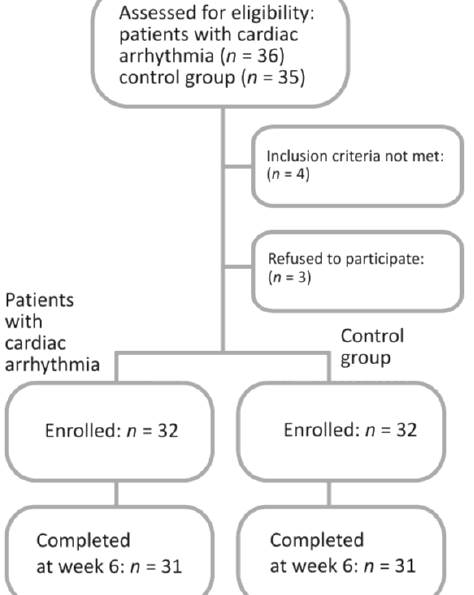
Figure 1. Flowchart of the participants in the study.